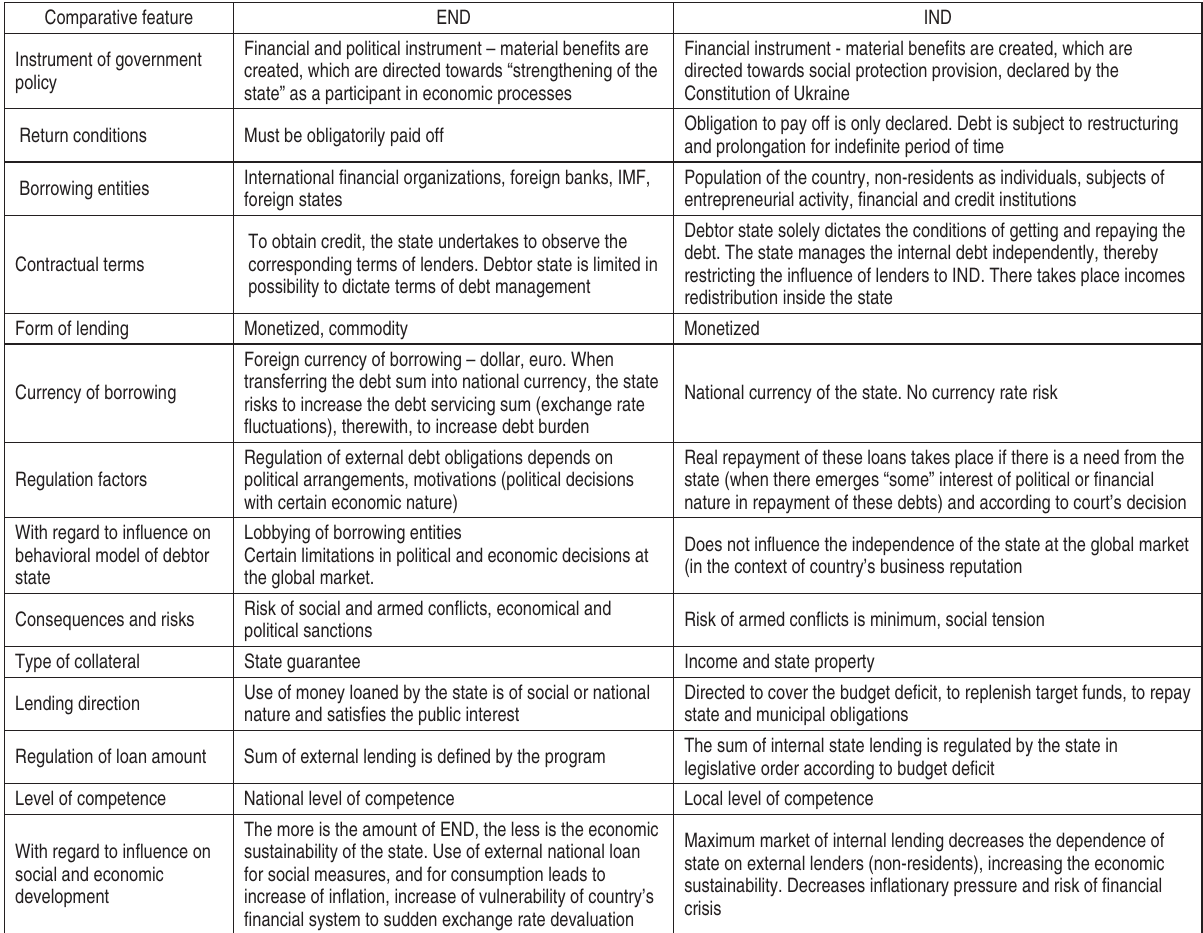
Table 3. Comparative characteristics of approaches to understanding of external and internal national debt from the viewpoint of its main features (Klymash, Bahatska, Demianenko,